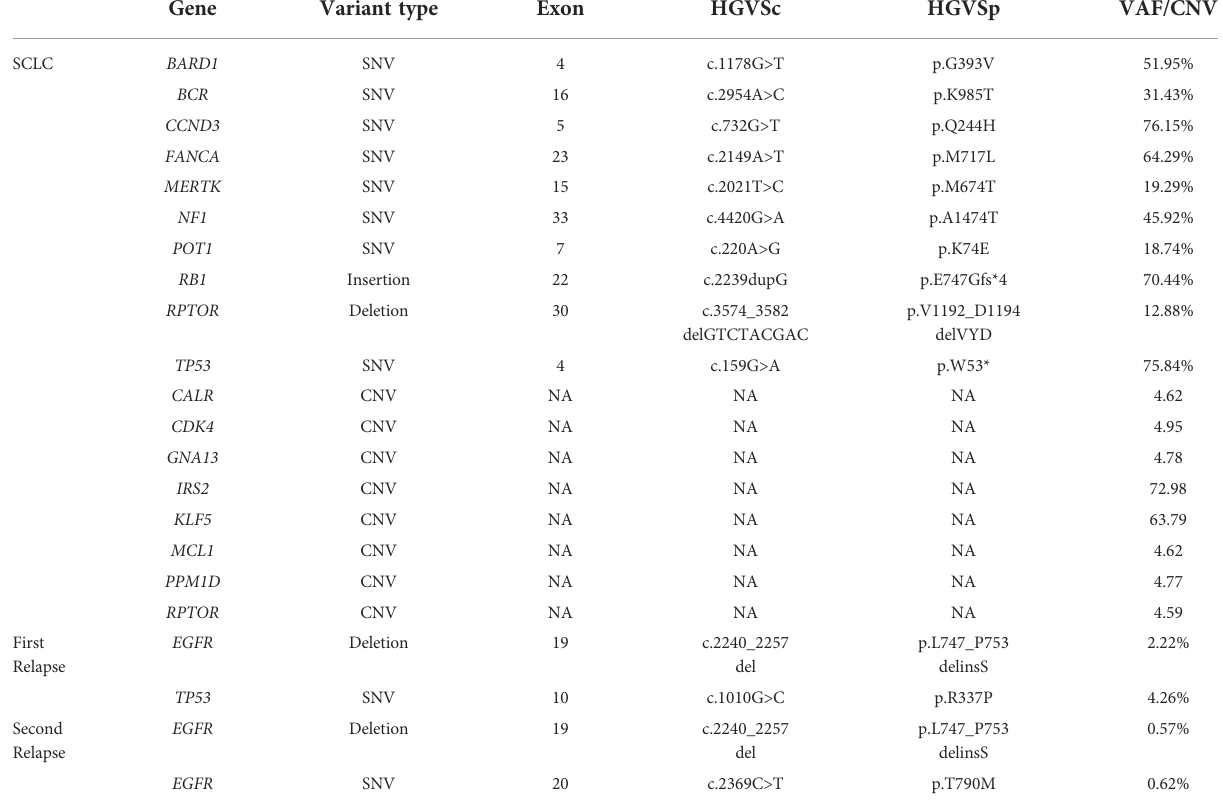
TABLE 1 Genetic variants in the case revealed by the CGP assasy.